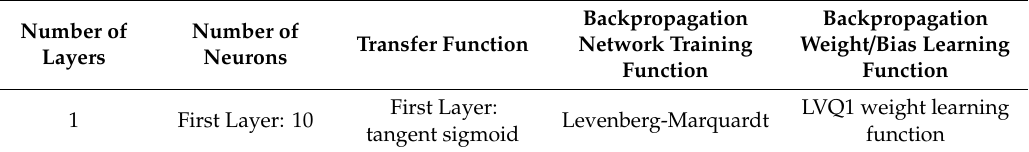
Table 3. Parameters used in the multilayer perceptron artificial neural network (ANN) to select the most e ff ective